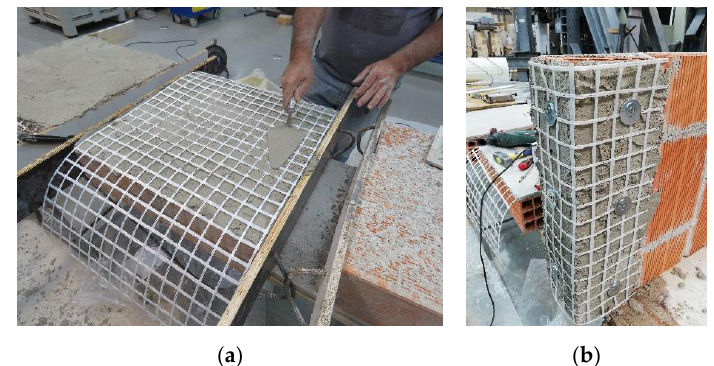
Figure 2. SSM group: ( a ) strengthening of the MIW (front view of the specimen); and ( b ) strengthening of the MIW (top and backside of the specimen).